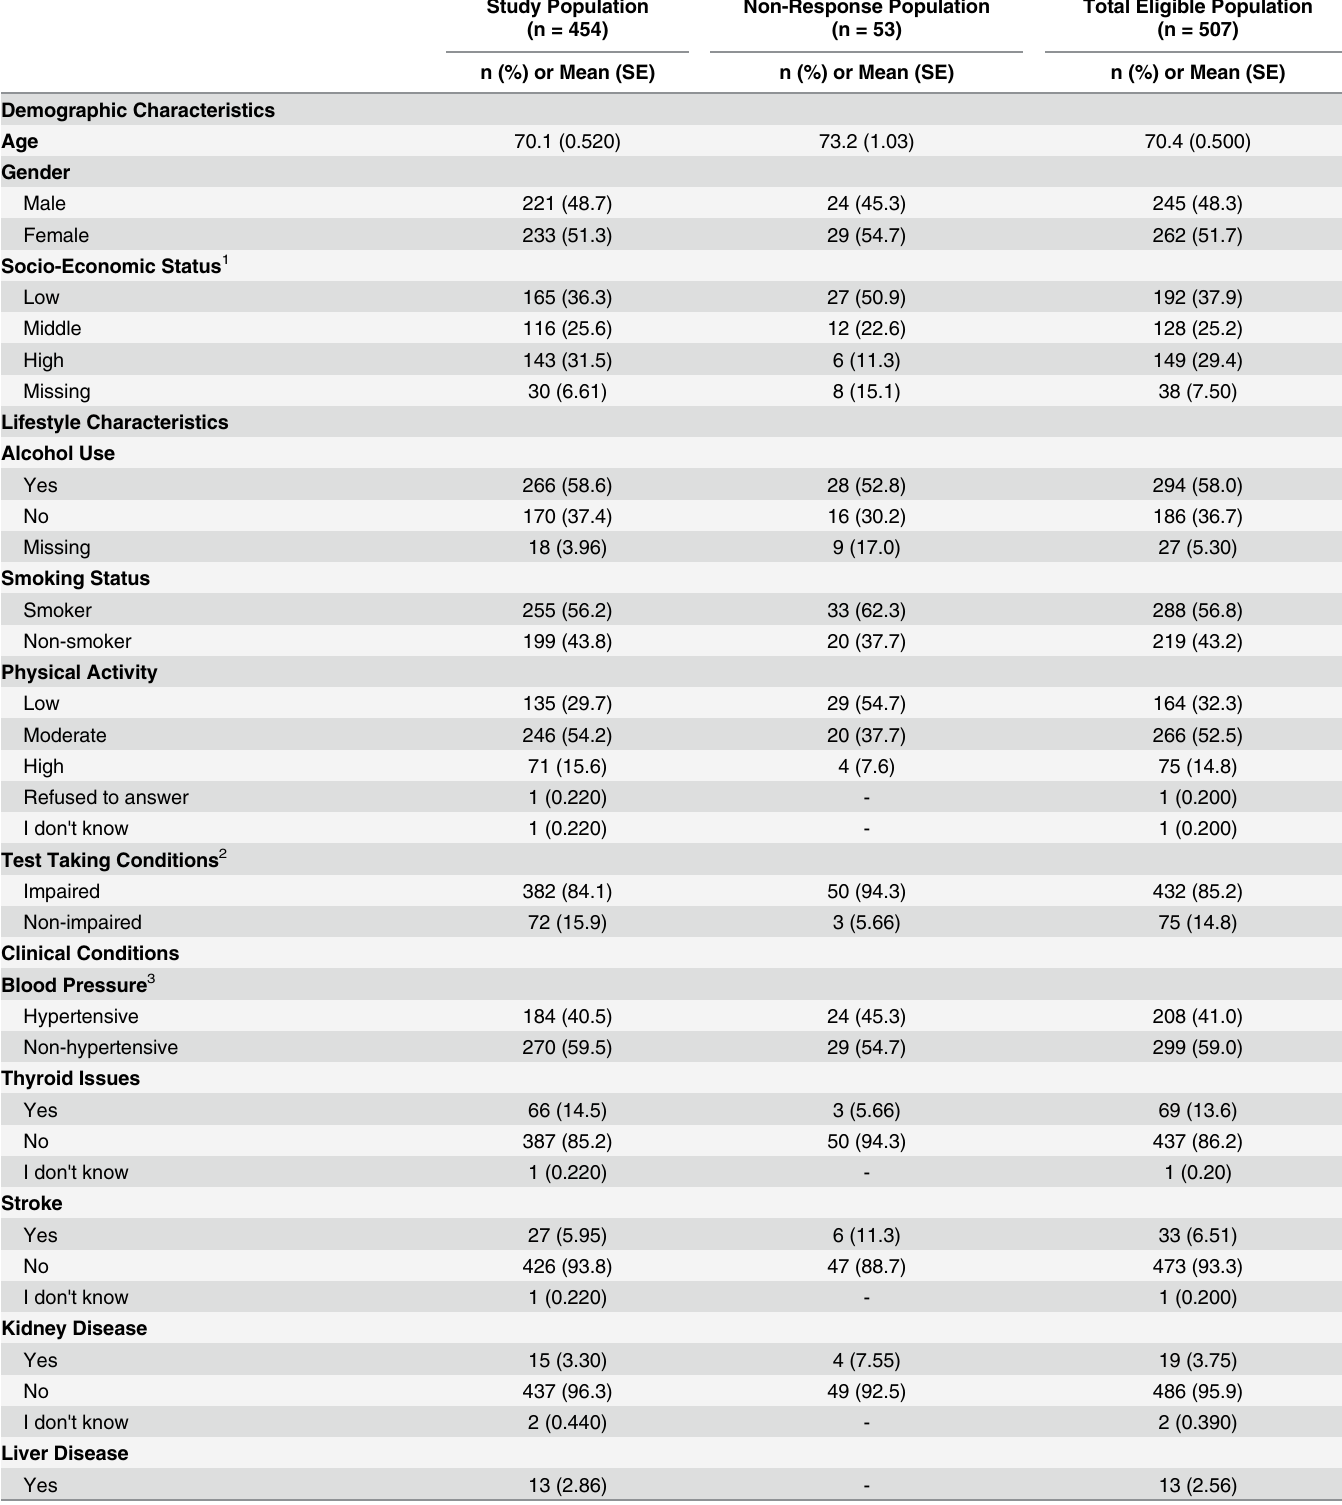
Table 1. Population Statistics for Study